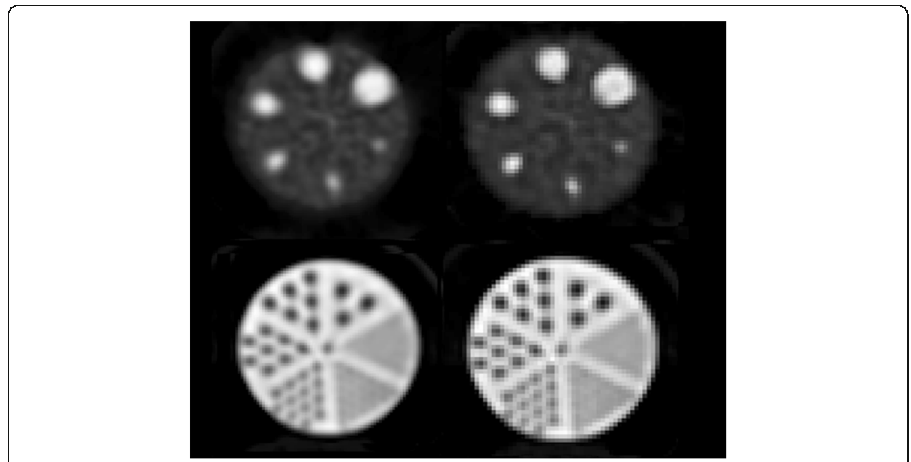
Fig. 3 Reconstructed images of Jaszczak phantom, with the top plane showing the hot spheres, with a sphere-to-background ratio of 4.4 to 1, and the bottom plane showing the cold rods insert. Left column shows the clinical, and the right column shows the research reconstruction results